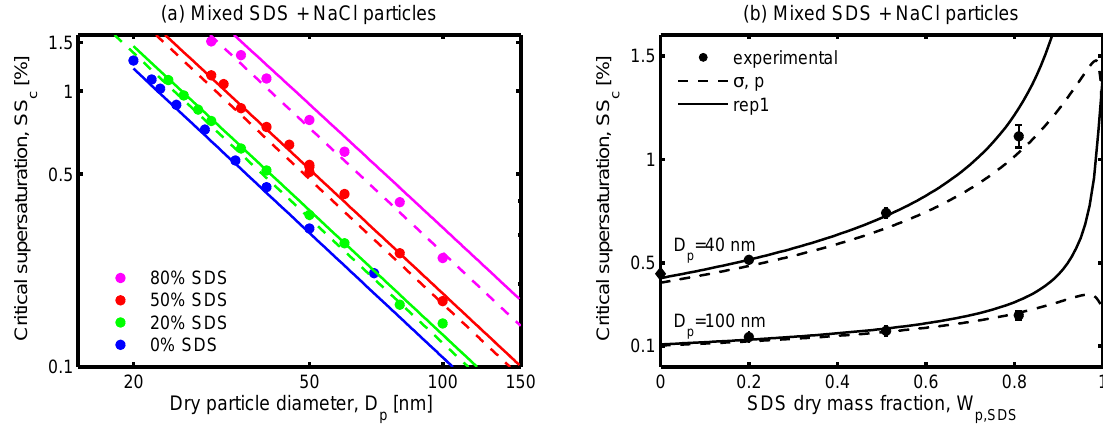
Fig. 5. Critical supersaturations ( SS c [%]) for particles comprising sodium dodecyl sulfate (SDS) mixed with sodium chloride (NaCl), as